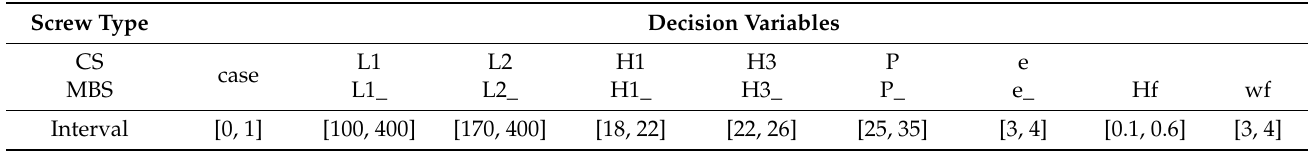
Table 4. Geometrical parameters of both CS and MBS screws.